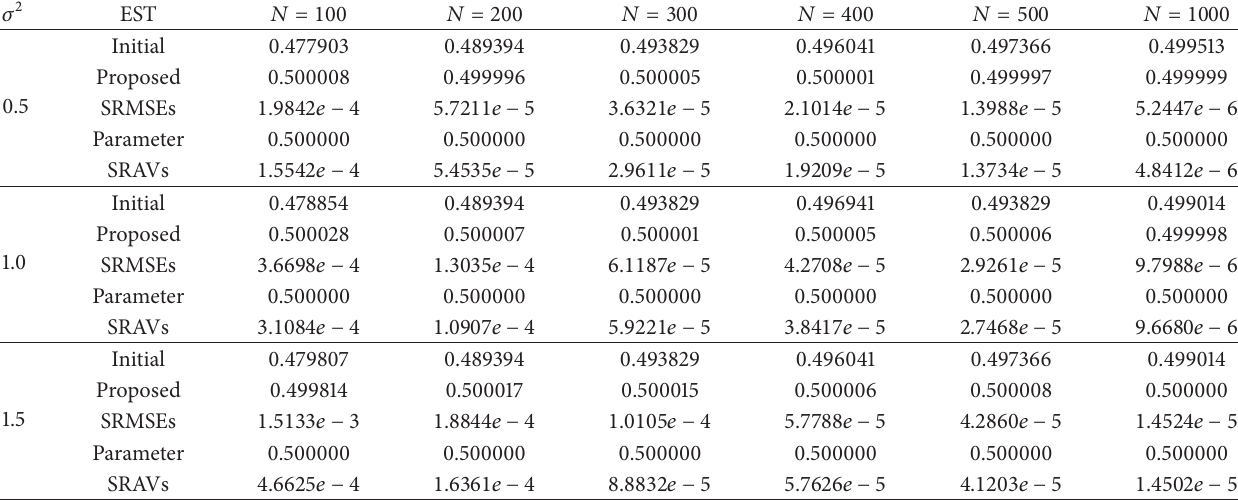
Table 2: The average estimates of the initial and proposed estimator based on 100 replications, as well as the corresponding SRMSEs and SRAVs of the frequency